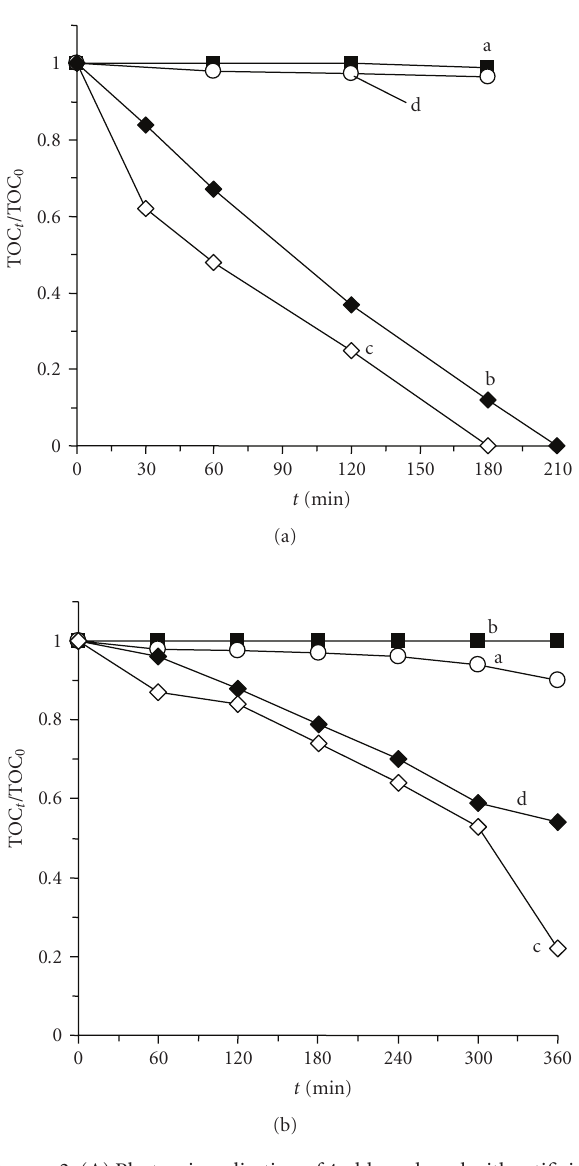
Figure 1: (A) Di ff use reflectance spectra of modified and pure TiO 2 , (B) plot of transformed Kubelka-Munk function versus the energy of the light absorbed; (a) TiO 2 , (b) TiO 2 -2.98%C, (c) TiO 2 - 0.42%C, (d) TiO 2 -0.03%C.